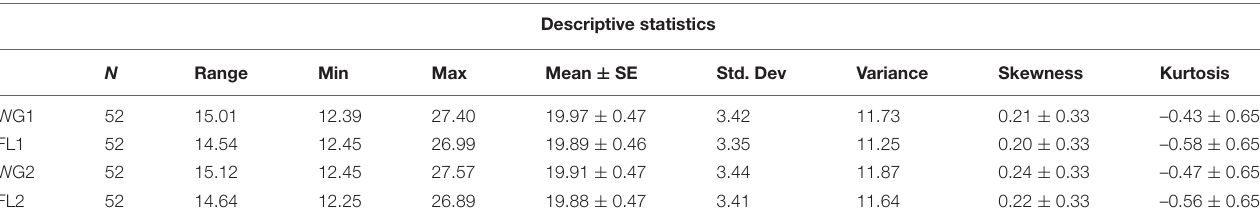
FIGURE 1 | The modified sample preparation method with digestion mixture for protein analysis using Kejdhal method. TABLE 2 | Descriptive statistical analysis showing range, mean, standard deviation, variance, skewness, and kurtosis for flour and whole-grain of the five oilseed